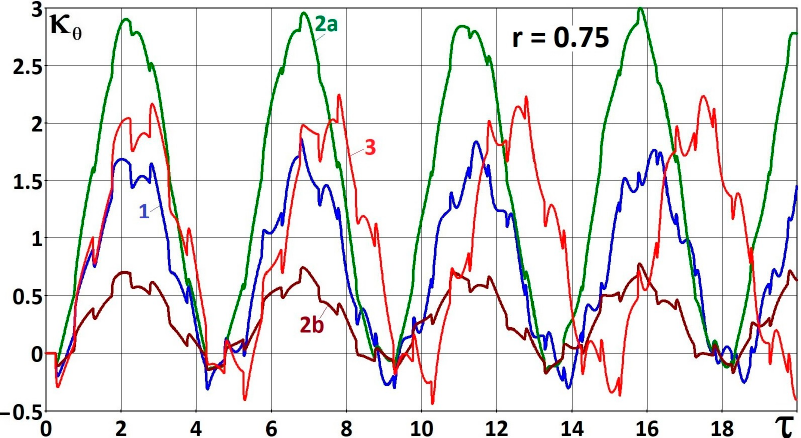
Figure 8. Time history of the relative circumferential stress at r = 0.75. Elastic materials. FGM cylinder—curve 1; two-layer cylinder—curves 2a (inner layer) and 2b (outer layer); homogeneous cylinder—curve 3.